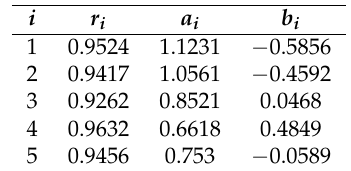
Table 3. Correlation coefficients and calibration coefficients of SCFSen